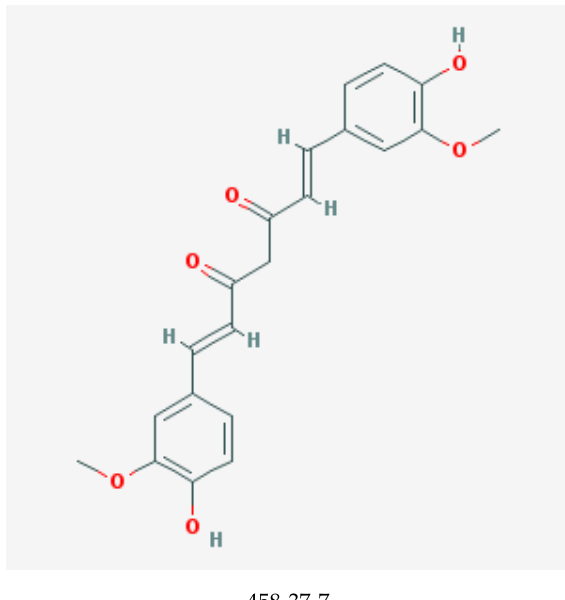
Figure 1. Chemical structure of curcumin with chemical abstracts service registry number (CASRN) [22].